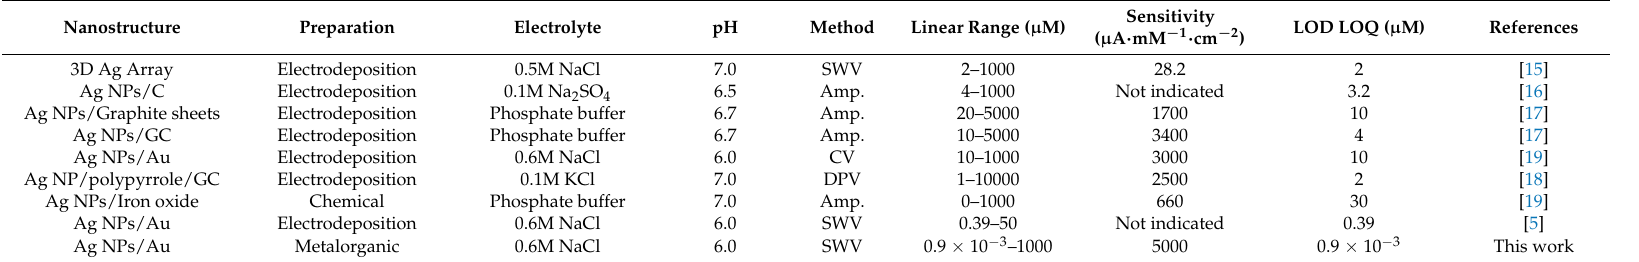
Table 1. Comparison of electrochemical sensors based on silver nanostructure for nitrate